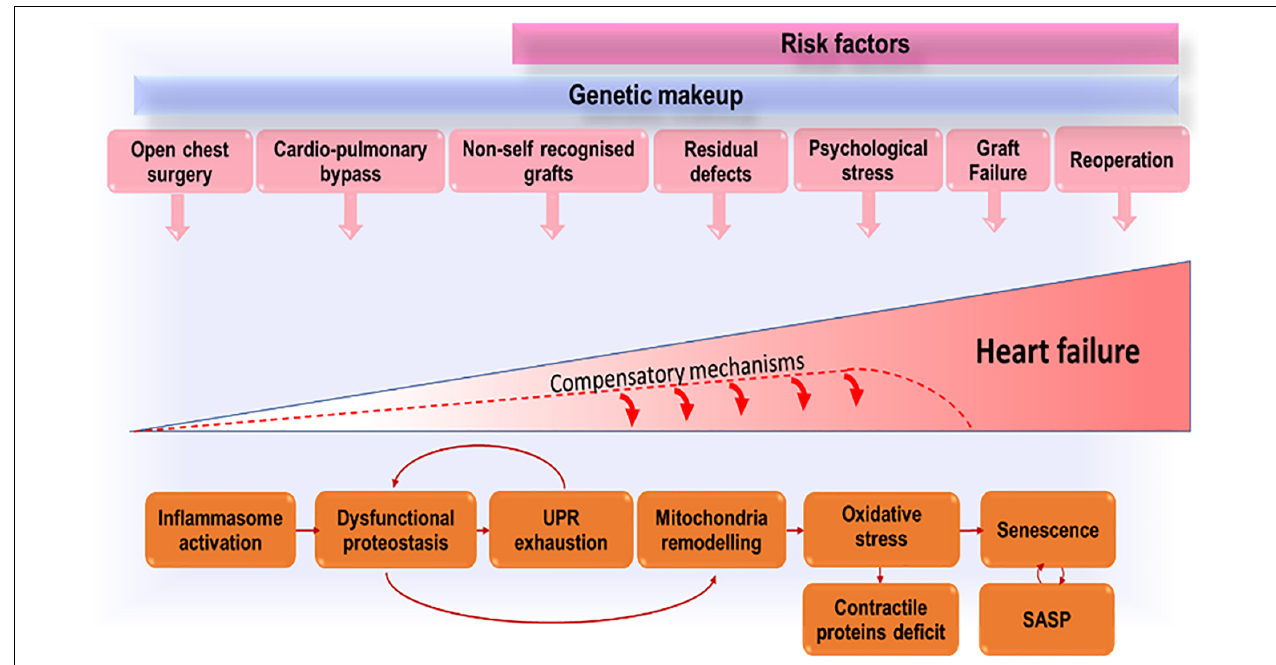
FIGURE 1 | Accruing stressors that, by inducing premature cells senescence, lead to exhaustion of compensatory mechanisms and eventually heart failure.